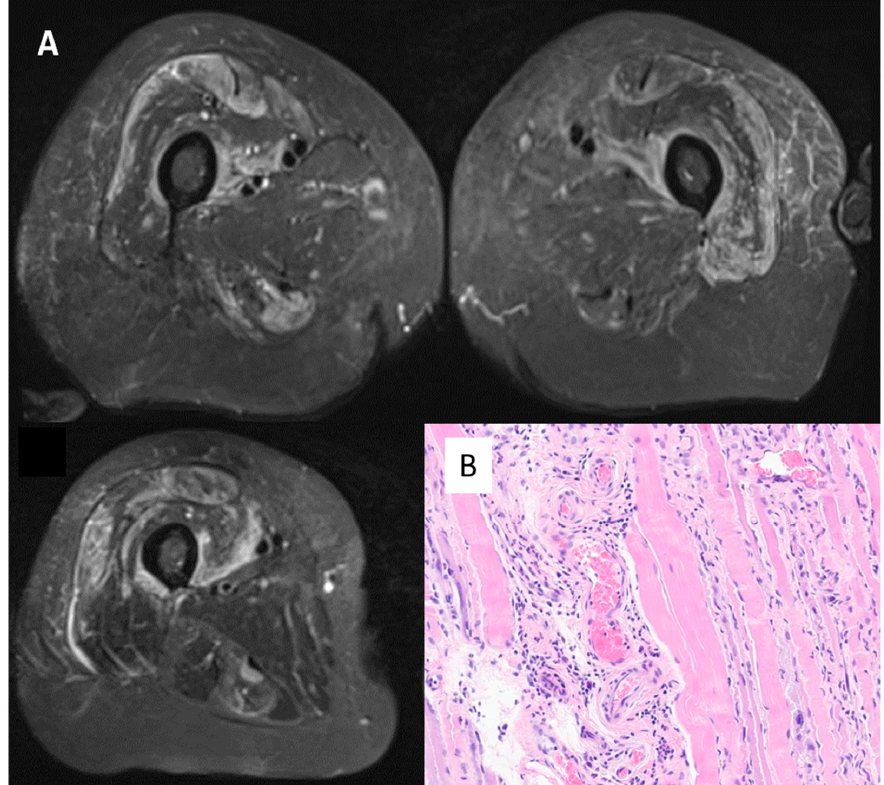
Figure 3. Panel ( A )—MRI scan of thighs from Case 1 (female, 68 years old). Oedema in the quadriceps (vastus intermedium femuri; vasti medialis and rectum femuri) bilaterally, pointing to inflammation in the muscle masses explored. Panel ( B )—Muscle biopsy from case 10 (female, 71 years old). Haematoxylin/Eosin, magnification 400×. Perimyseal pathology with local thrombosis consistent with a vasculopathy and macrophages present consistent with immune-mediated necrotising myositis. Anti 3-hydroxy-3-methylglutaryl-coenzyme A reductase antibodies were positive. In total, 13 cases were treated with corticosteroids and/or immunosuppressants (12 cases) as detailed in Table 1. With the exception of case 12, patients described in this series improved (both in amelioration of strength and CK level reductions after treatment, alt- hough time-to-recovery and degree of recovery differed across cases (Table 2). Complica- tions such as aspiration pneumonia, cataract, pulmonary embolism, anuria, respiratory arrest and stroke occurred in 5 cases (Table 1).